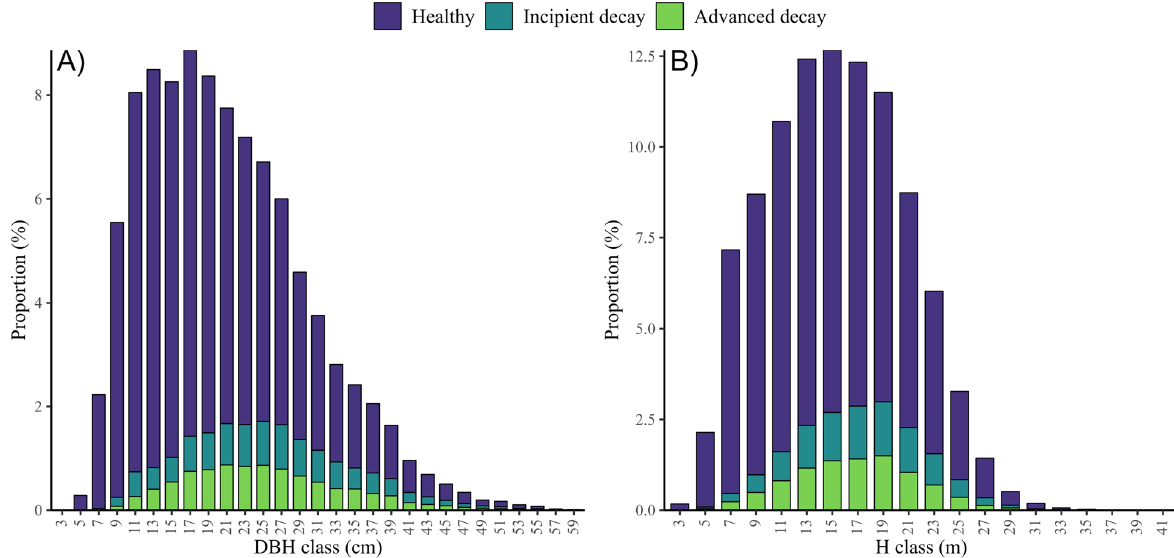
Fig. 2 The diameter ( A DBH) and height ( B H) distribution of harvested healthy and decay-affected trees in the harvester data. The decay-affected trees were categorized into incipient and advanced decay